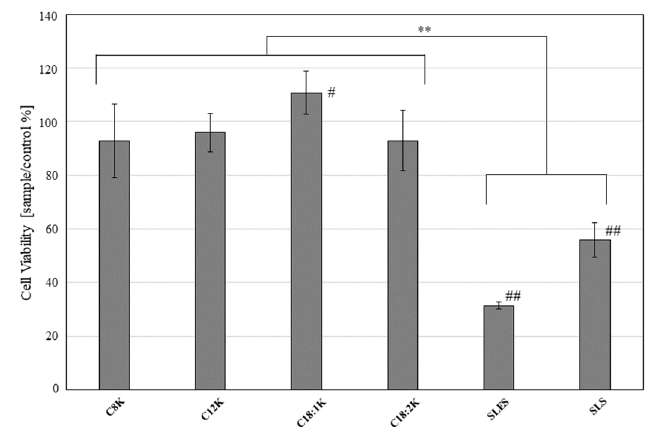
Figure 5. Viability of NHEK-Ad cells treated with 0.5 mM fatty acid potassium, SLES, or SLS for 5 min. Untreated cells were used as the control. Percentage cell viability was calculated relative to the control value. Results are expressed as mean ± SD values ( n = 6). ** p < 0.01, # p < 0.05 and ## p < 0.01 compared to the control.